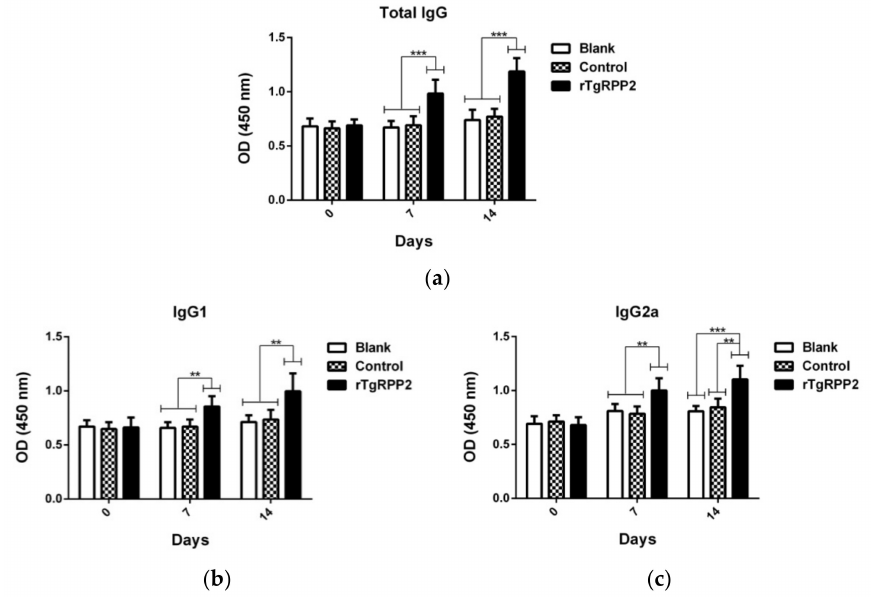
Figure 8. Determination of total IgG ( a ) and subclass IgG1 ( b ) and IgG2a ( c ) antibodies in the sera from animals vaccinated with PBS, pET32a vector protein, and rTgRPP2. Results were evaluated using one-way ANOVA analysis, followed by Dunnett’s test, and shown as the mean of OD450 ± standard deviation ( n = 5). ** p < 0.01 and *** p < 0.001 compared with the blank group or the control